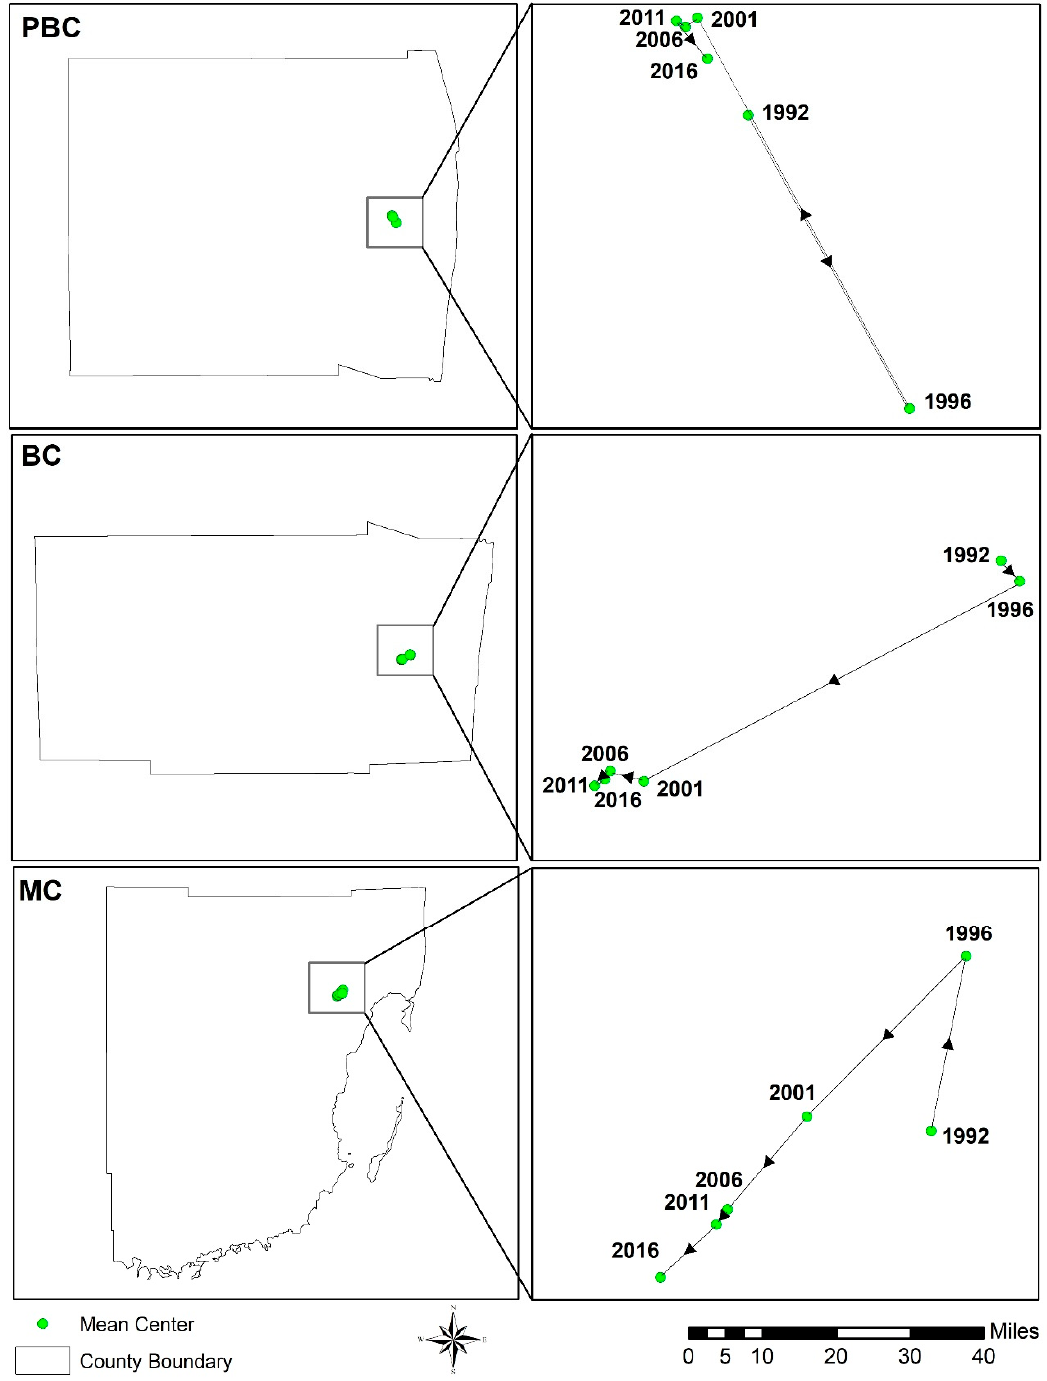
Figure 10. Change of direction in the mean center in the tri-county region.